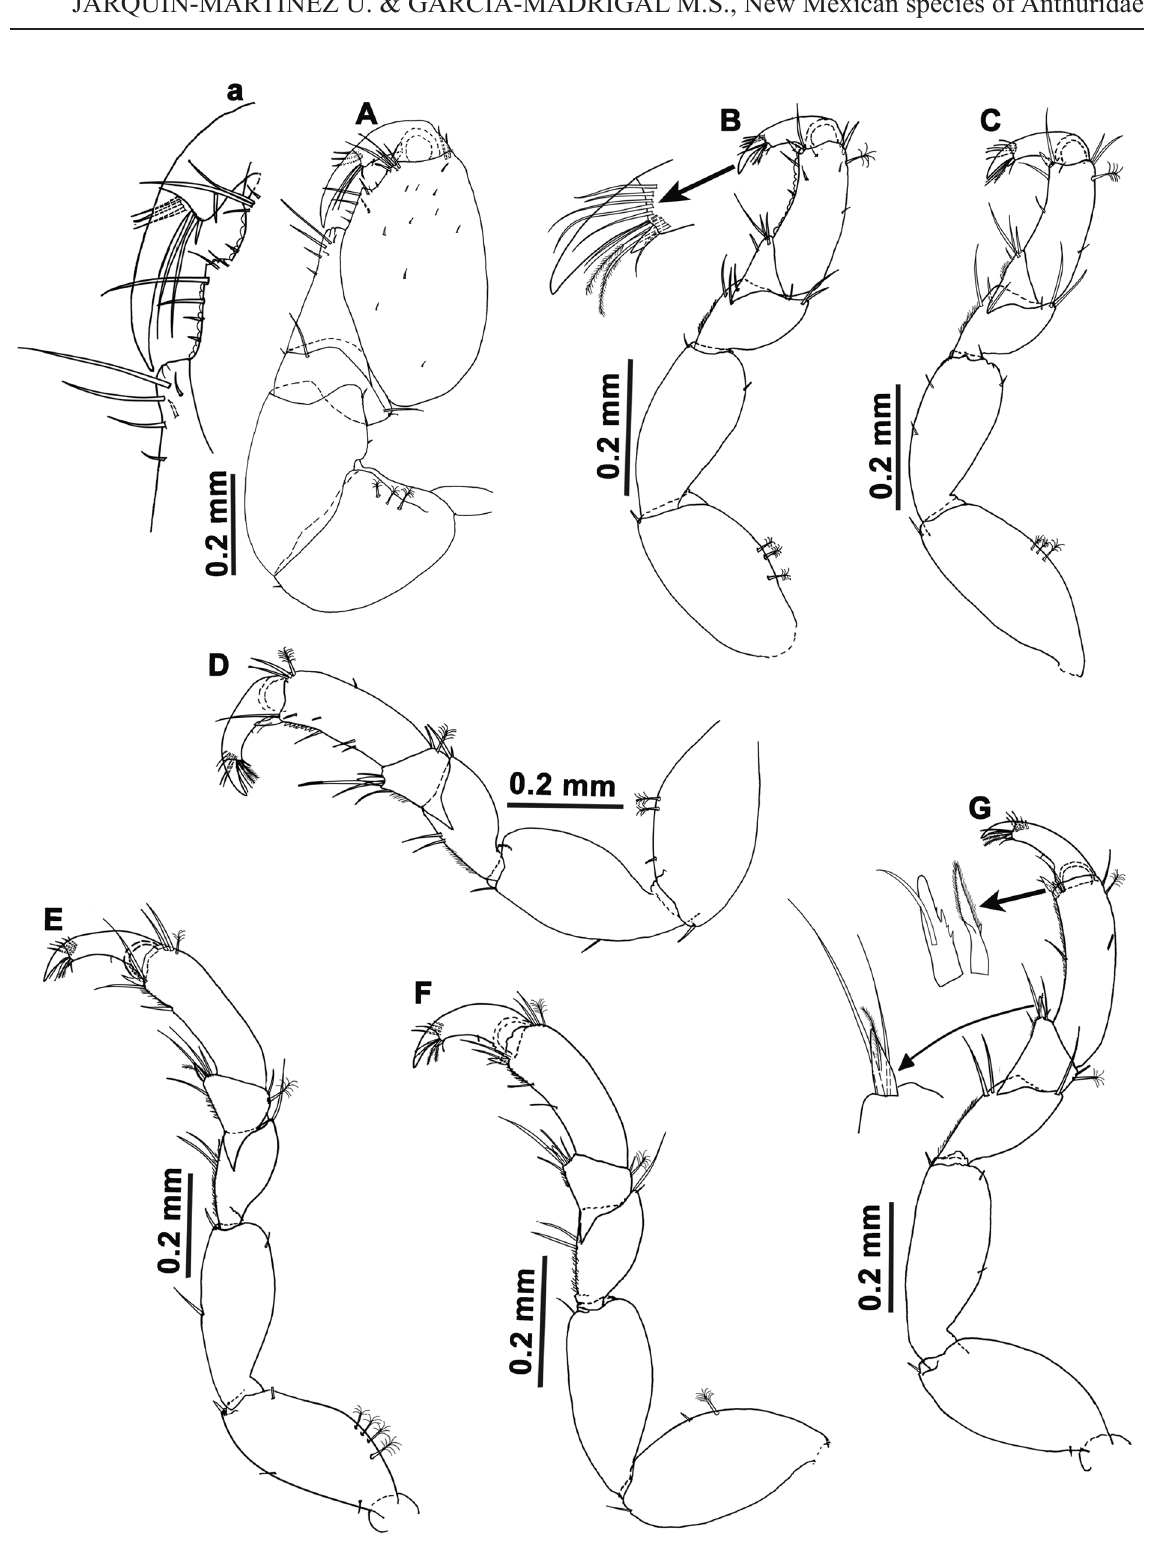
Fig. 12. Mesanthura estacahuitensis sp. nov., holotype, ♀, 6.8 mm, Oaxaca, Puerto Ángel, Estacahuite Beach (UMAR-PERA 547). A . Pereopod 1 and detail of the palm (a). B . Pereopod 2 and detail of the dactylus. C . Pereopod 3. D . Pereopod 4. E . Pereopod 5. F . Pereopod 6. G . Pereopod 7 and detail of carpus and sensory